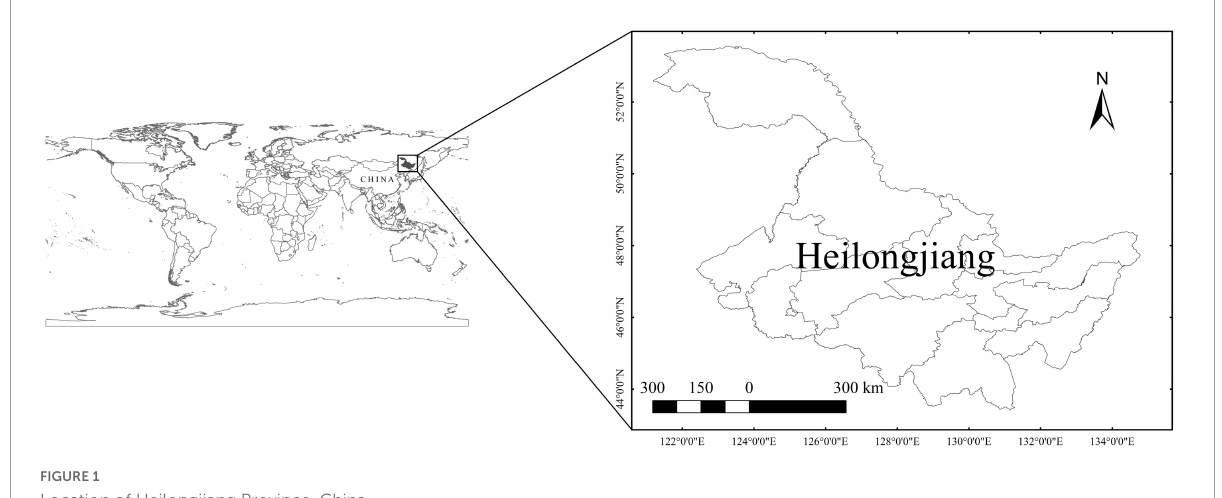
FIGURE1 Location of Heilongjiang Province,